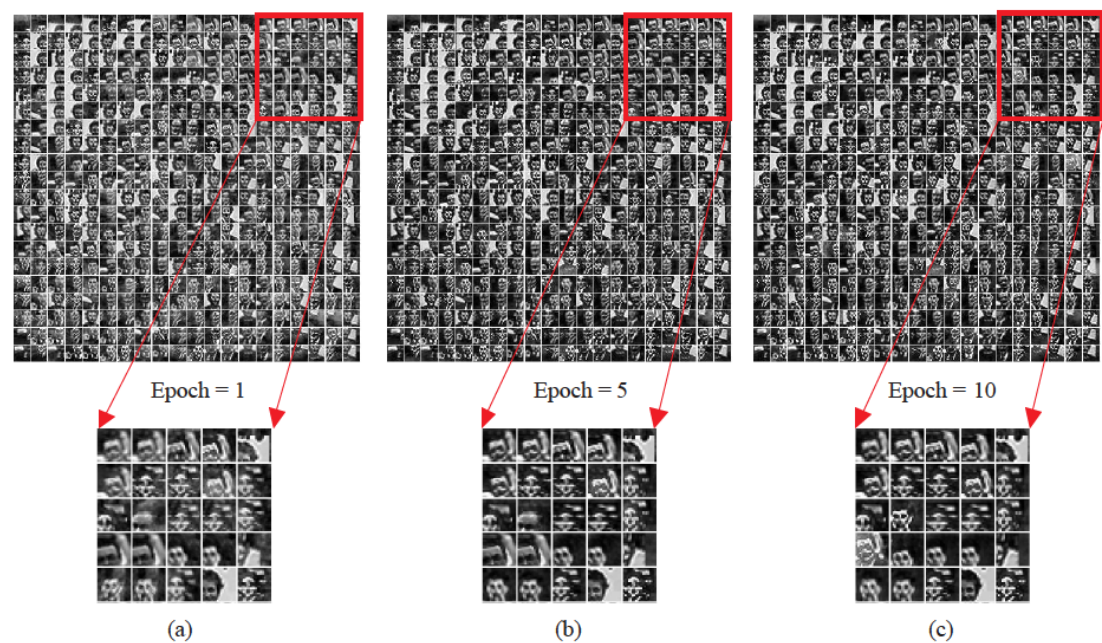
Figure 9: The second neuron regenesis